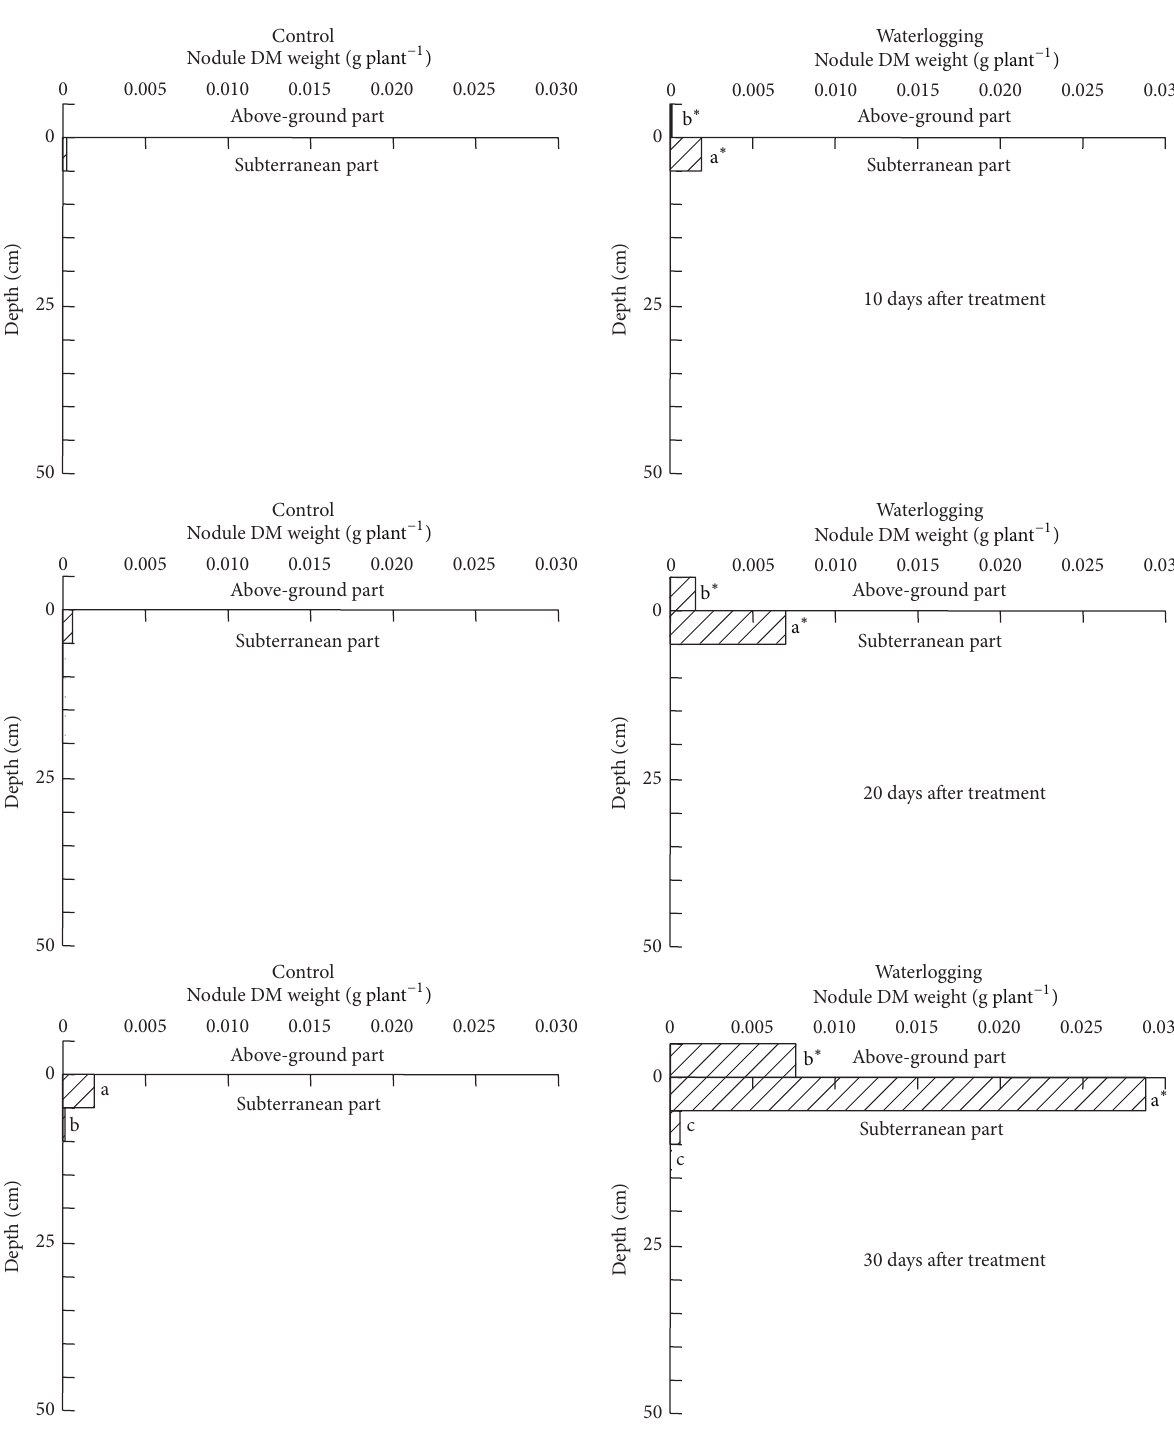
Figure 2: Distribution of nodules from 10 to 30 days after treatment in experiment 1. Symbols with different letters within the same investigation date and treatment show significant differences ( 𝑃 < 0.05 ). ∗ Significantly different ( 𝑃 < 0.05 ) between control and waterlogging treatment with the same root